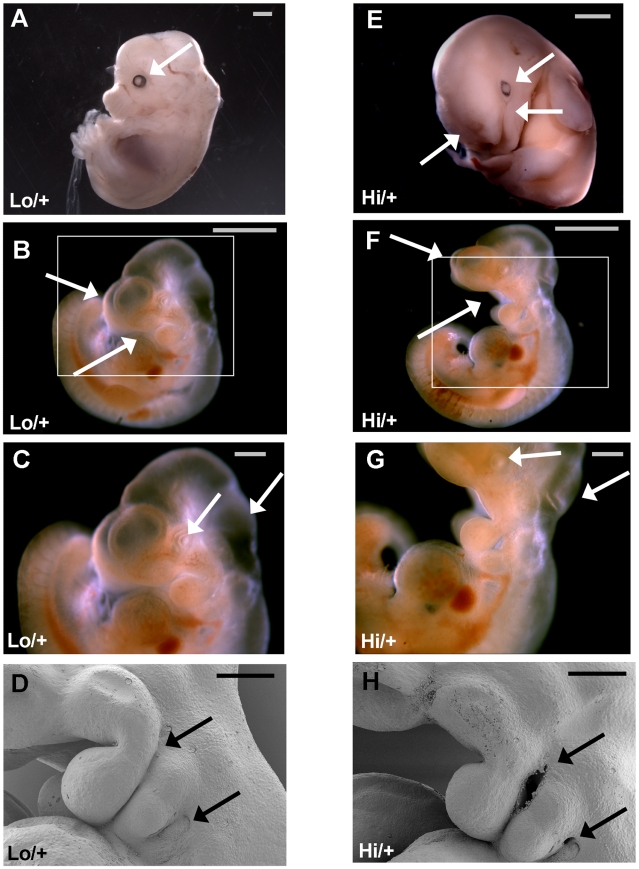
E14.5 and E10.5 embryos.A) and E) are fixed embryos at E14.5 from a cross between Ctgf Lo/+ and EIIa-Cre +/− B6.129 mixed background parents. A) is a normal Lo/+ and E) is a small atypical Hi/+ at higher magnification. Top arrow denotes less developed eye in E) and the lower two arrows point to lateral and midline facial clefting, respectively. Embryos B) to D) and F) to H) are E10.5 embryos from a cross between Ctgf Lo/Lo and EIIa-Cre +/− 129/SvEv background parents. B), C), and F), G), are unfixed embryos. B), C) and D) are normal Ctgf Lo/+ embryos. F), G), and H) are Ctgf Hi/+ embryos. The top arrow in B) and F) points to the forebrain which appears smaller in F) and the lower arrow points to the mouth gape in F) also indicative of a small forebrain. The top arrow in C) and G) points to the eye and the bottom arrow points to the hindbrain which both appears abnormal in G). The pictures in D) and H) are from scanning electron microscopy. The arrows in D) and H) point to the first (top) and second (bottom) pharangeal (branchial) clefts. In D) there is normal closure of the clefts and in H) the clefts are abnormally patent (open). B) and C) are the same embryo and F) to H) are the same embryo. The bars in A), B), E), and F) represent 1000 µm and in C), D), G), and H) the bars represent 250 µm.